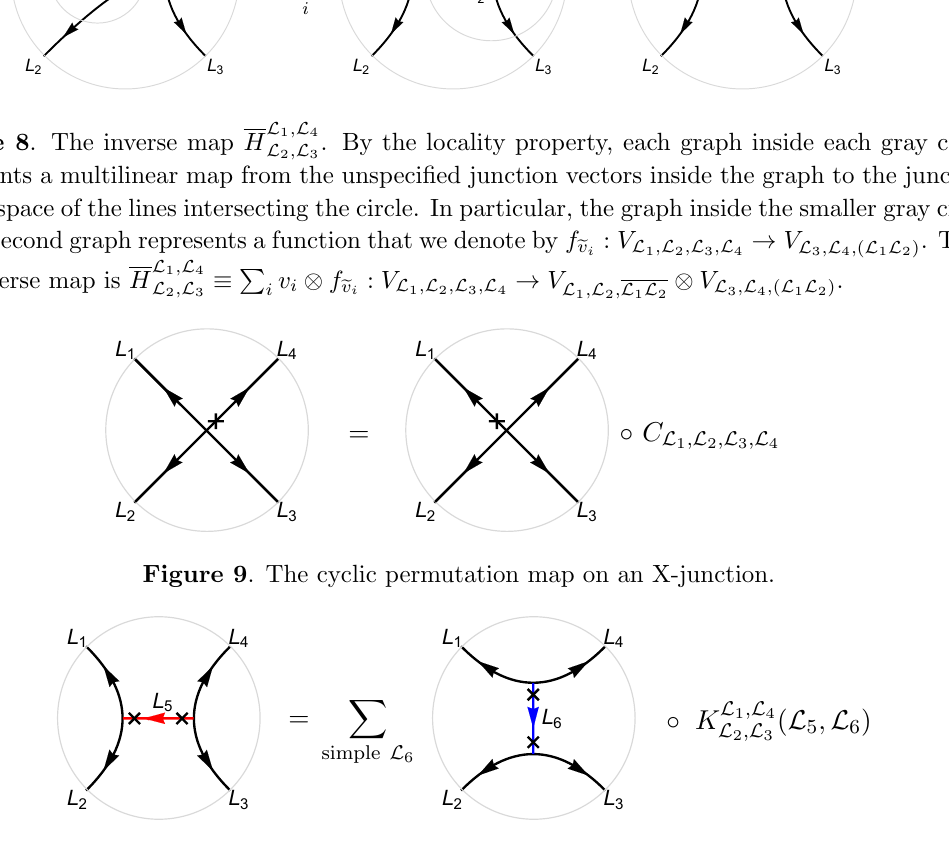
Figure 10 . The H-junction crossing relation. Note that the crossing kernel K L 1 ; L 4